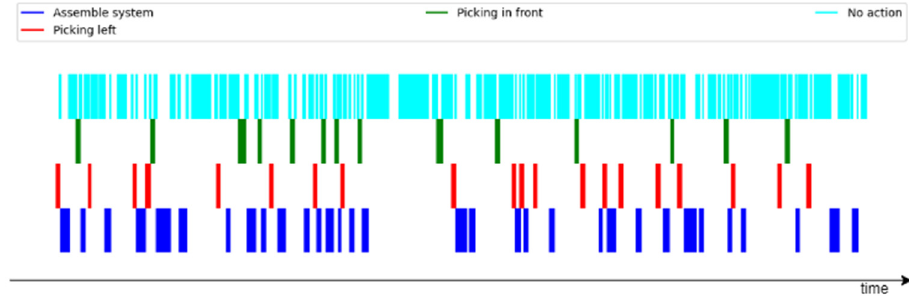
Figure 3. Relevant activity event distribution over one recording in the InHARD dataset.